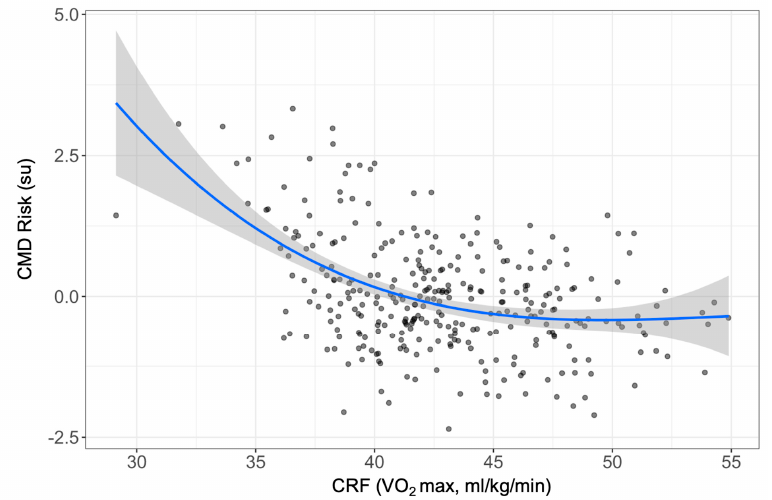
Figure 2. Association between Cardiorespiratory Fitness and Cardiometabolic Disease Risk. Scat- terplot displaying the nonlinear relationship between CRF (VO 2 max) and CMD risk. The y -axis (CMD risk score) is based on the re-standardized and summed results of the factor analysis of the CMD risk variables such that the CMD risk scores are based on a 1 standard deviation unit change. We considered CMD risk scores of < − 1, − 1 to 1, and >1 as low-, normal-, and high-CMD risk, respec- tively. Abbreviations: CMD, Cardiometabolic disease, CRF, cardiorespiratory fitness; su, standard- ized units, VO 2 max, maximal volume of oxygen consumption (cardiorespiratory fitness).